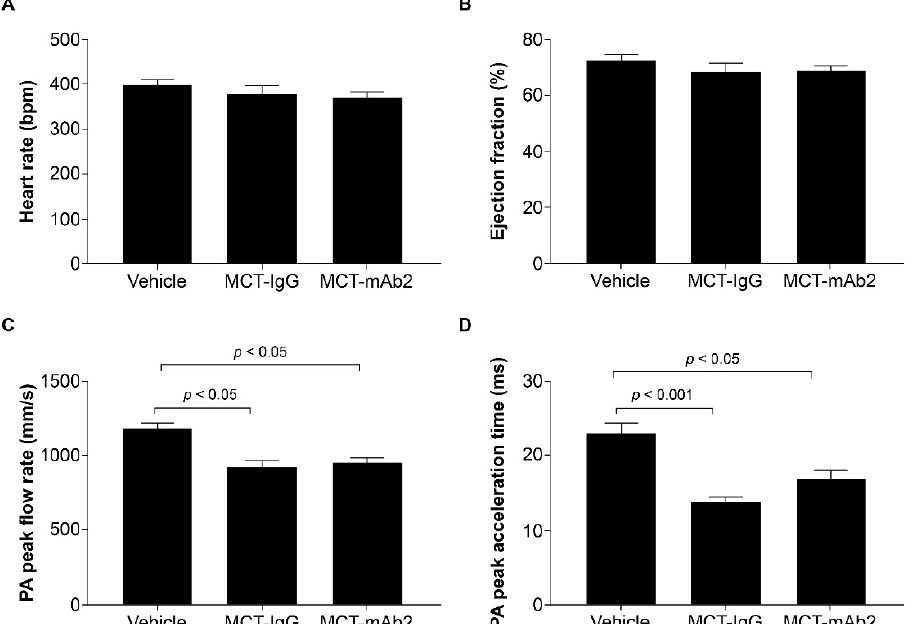
Figure 3. No effect of GDF15 mAb2 treatment on MCT-induced cardiac function impairment. ( A ) Heart rate (bpm) at day 16 post-MCT and GDF15 mAb2 dosing. Data were analyzed using one-way ANOVA. ( B ) Ejection fraction (%) at day 16 post-MCT and GDF15 mAb2 dosing. Data were ana-